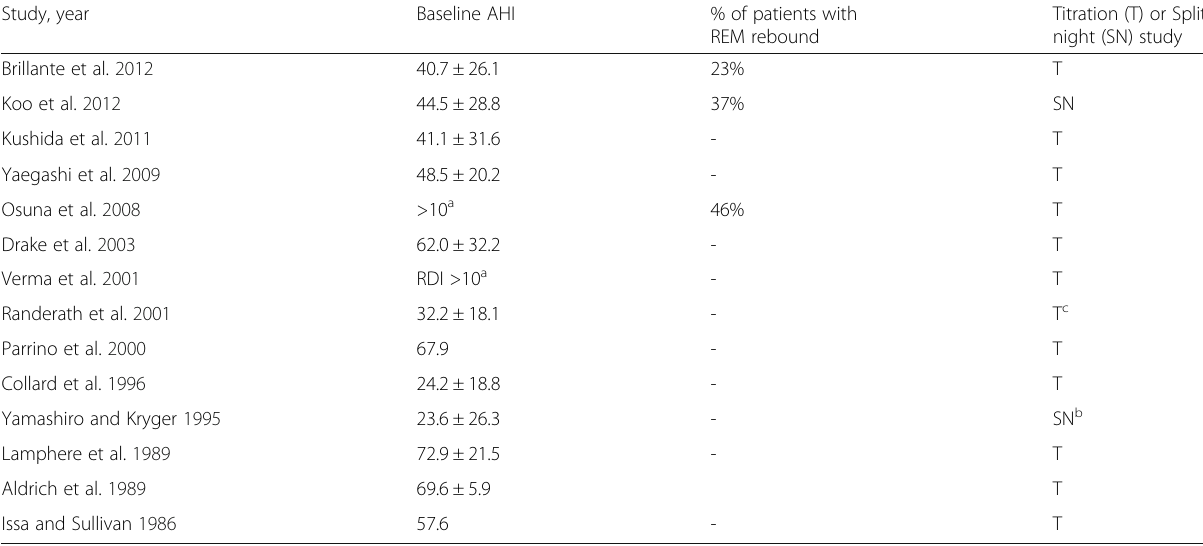
Table 2 REM rebound on CPAP titration: PSG parameters